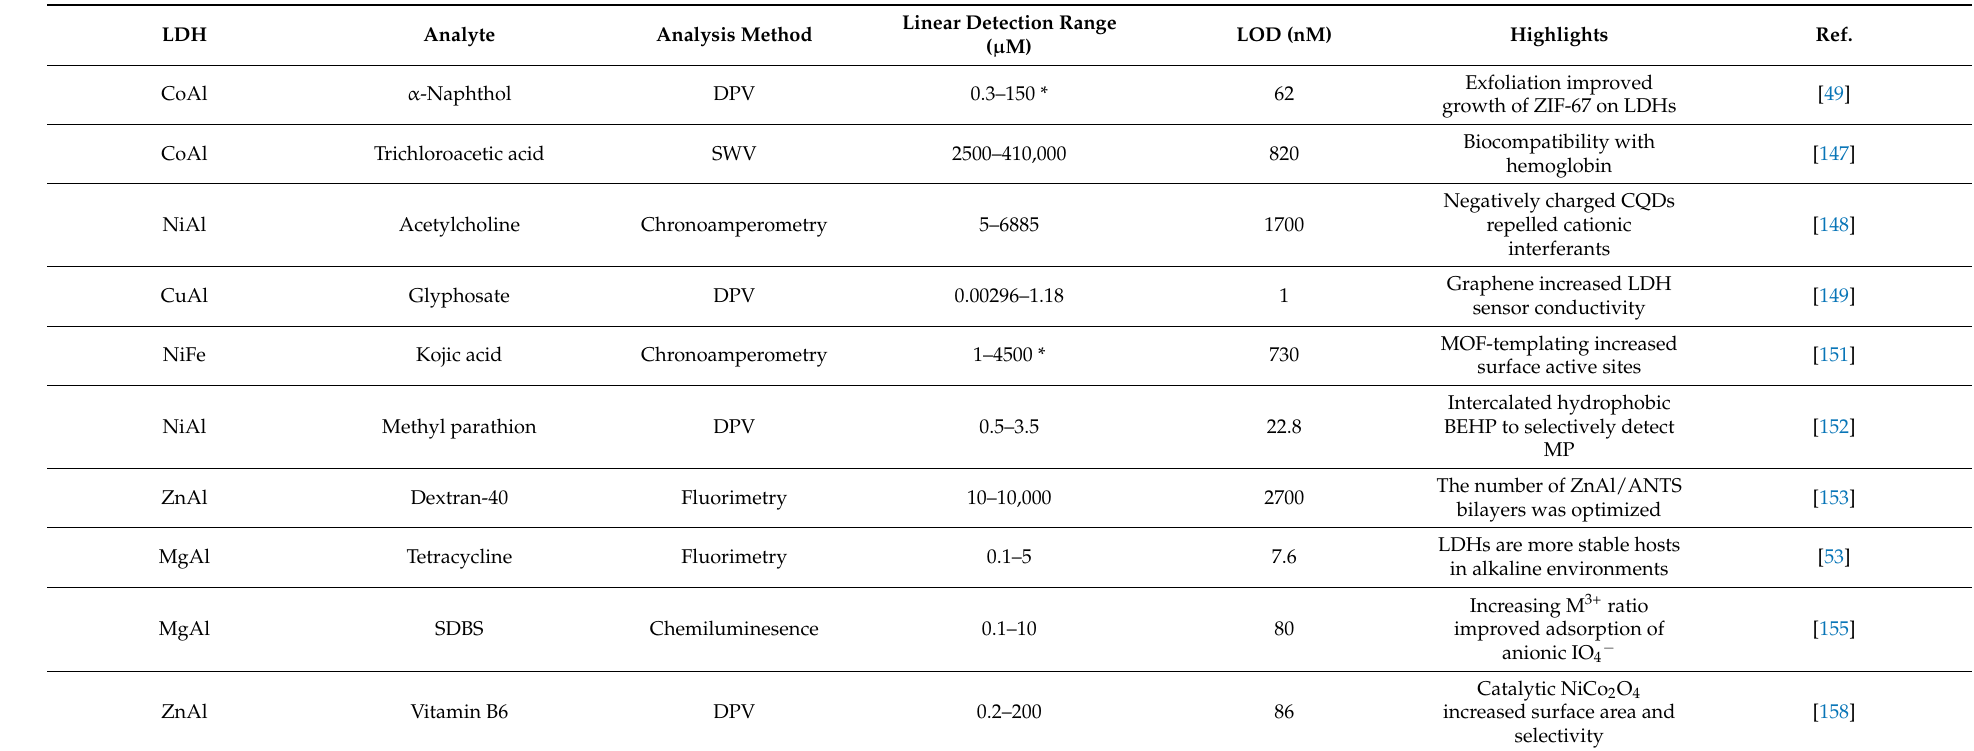
Table 6. The detection performance of LDH-based sensors for various organic